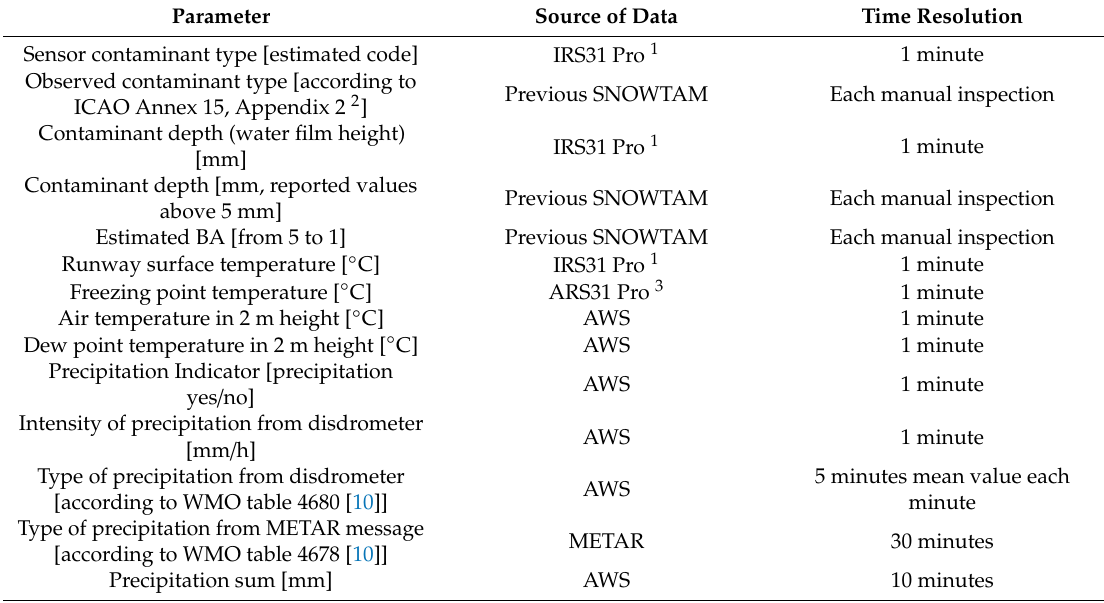
Table 1. List of parameters used for the Runway Condition Code (RWYCC) computation. AWS stands for Automated Weather